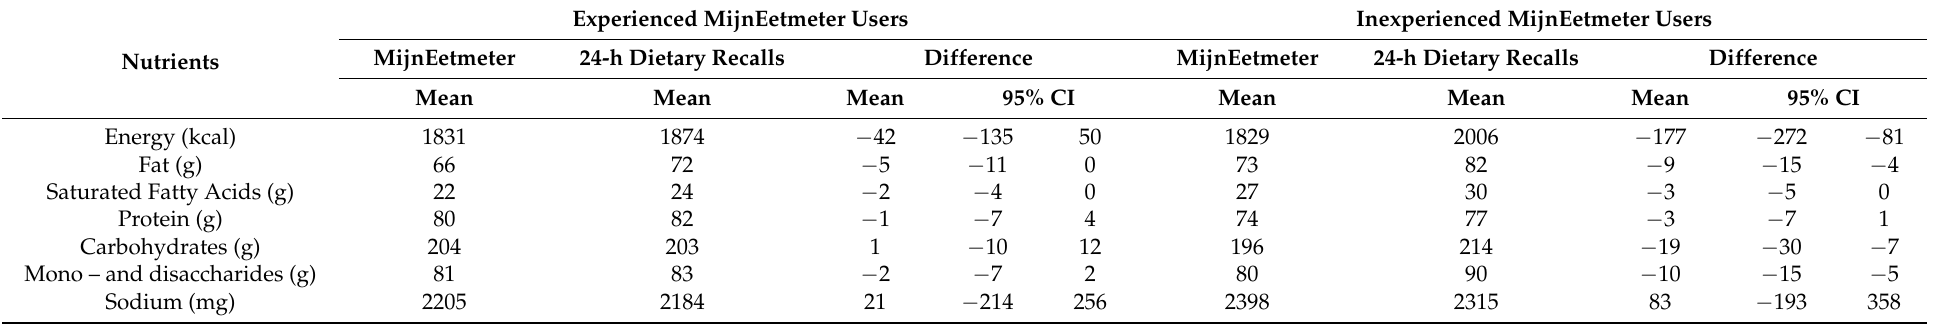
Table 4. Mean and differences in energy and nutrient intakes as assessed with ‘MijnEetmeter’ and with 24-h dietary recalls in experienced ( n = 47) and inexperienced ‘MijnEetmeter’ users ( n = 53) in MijnEetmeter Study